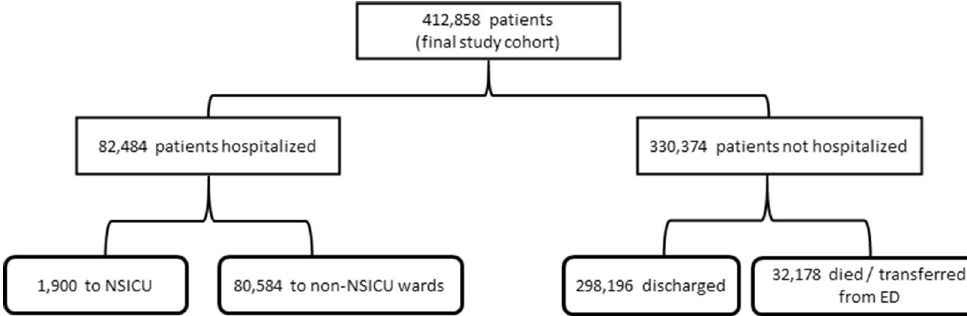
Figure 3. Cohort disposition. NSICU neuroscience intensive care unit.